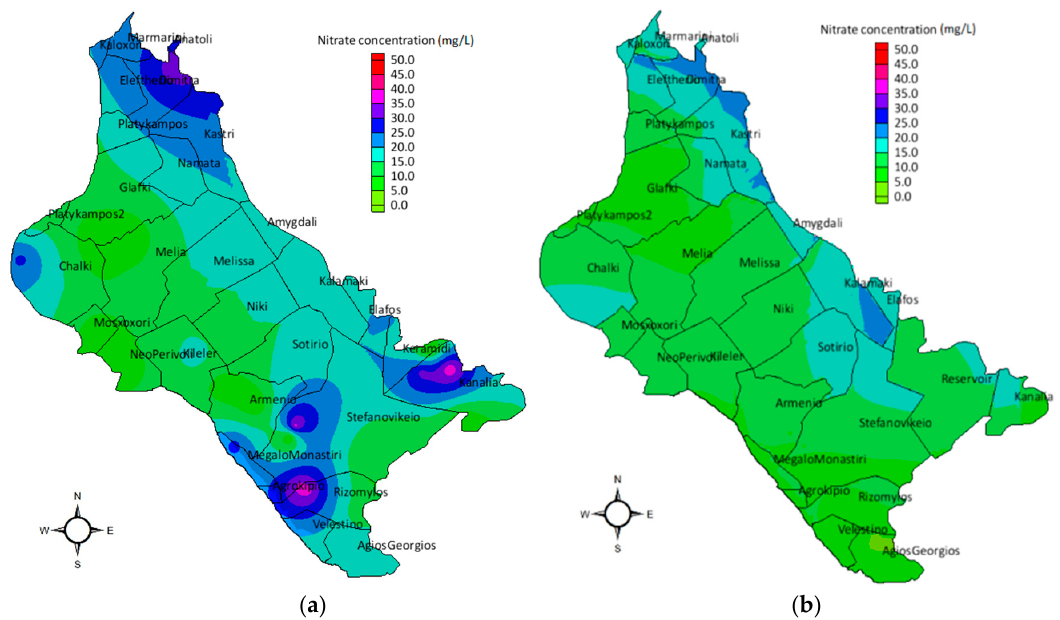
Figure 6. Hydraulic head results of the operational scenarios modeling: ( a ) No-reservoir scenario hydraulic heads; ( b ) reservoir scenario hydraulic heads.